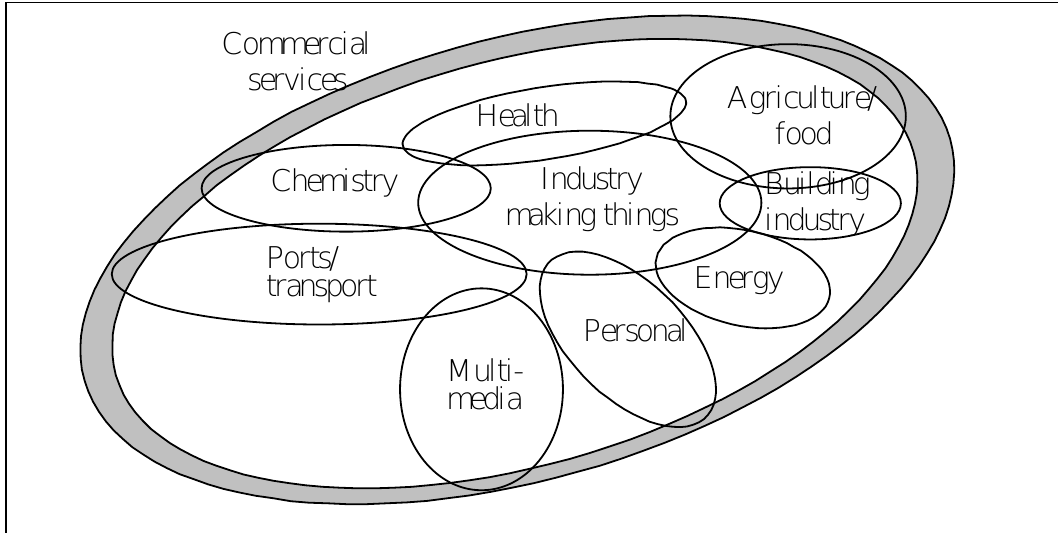
Figure 4. Dutch economic